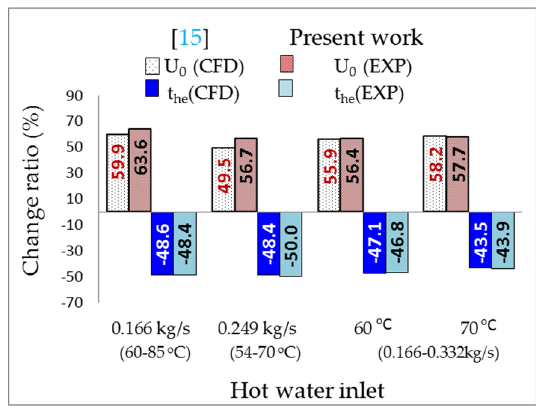
Figure 14. Change ratios of the U 0 and t he values.